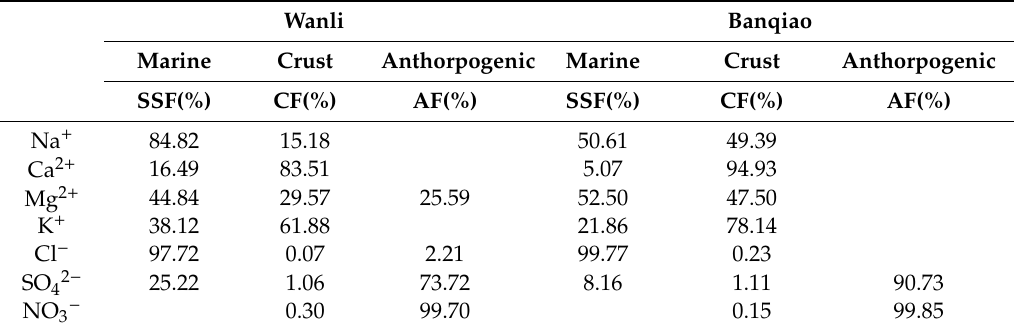
Table 3. Contributions of the source for major